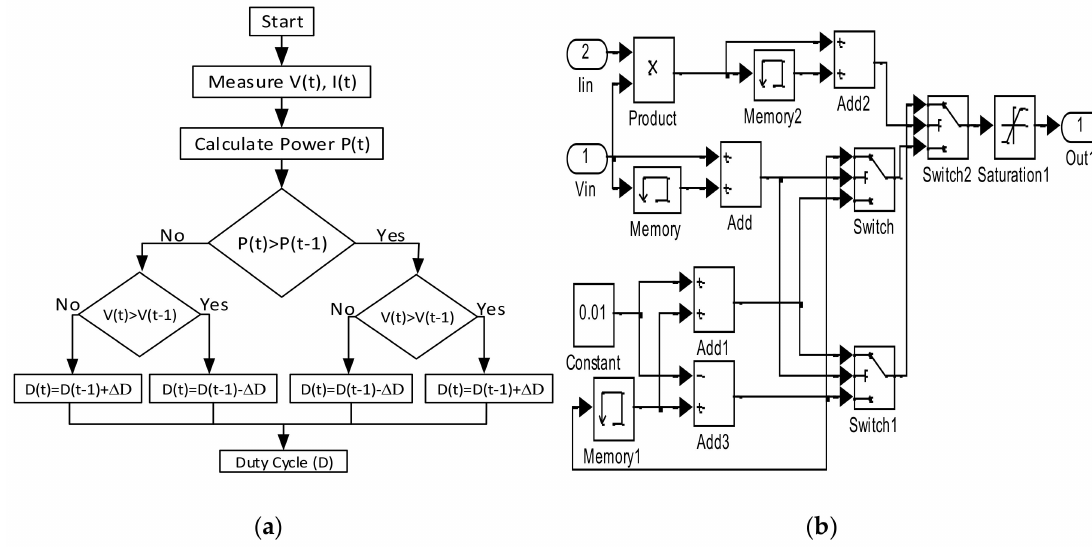
Figure 8. ( a ) The perturb and observe (P&O) method algorithm, ( b ) MATLAB / Simulink model of maximum power point tracker